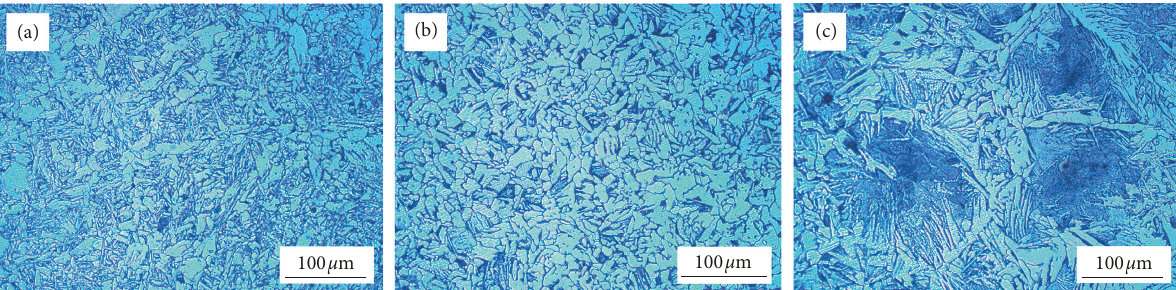
Figure 2: Microstructure in different areas of welded structure. (a) Weld joint. (b) HAZ. (c) Fusion line.